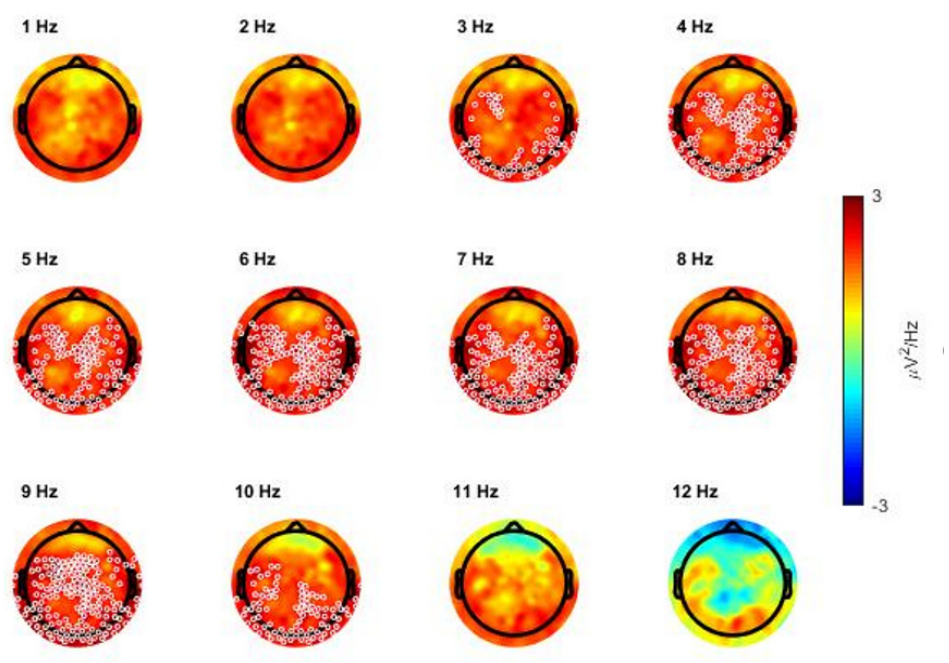
Figure 3. Topographical distribution of the comparison (single electrode t -value, 2-tailed, unpaired) between absolute power values of the attention-deficit/hyperactivity disorder (ADHD) group and of the healthy control group during whole-night non-rapid eye movement NREM sleep stage 3 (N3), represented per bin of frequency.